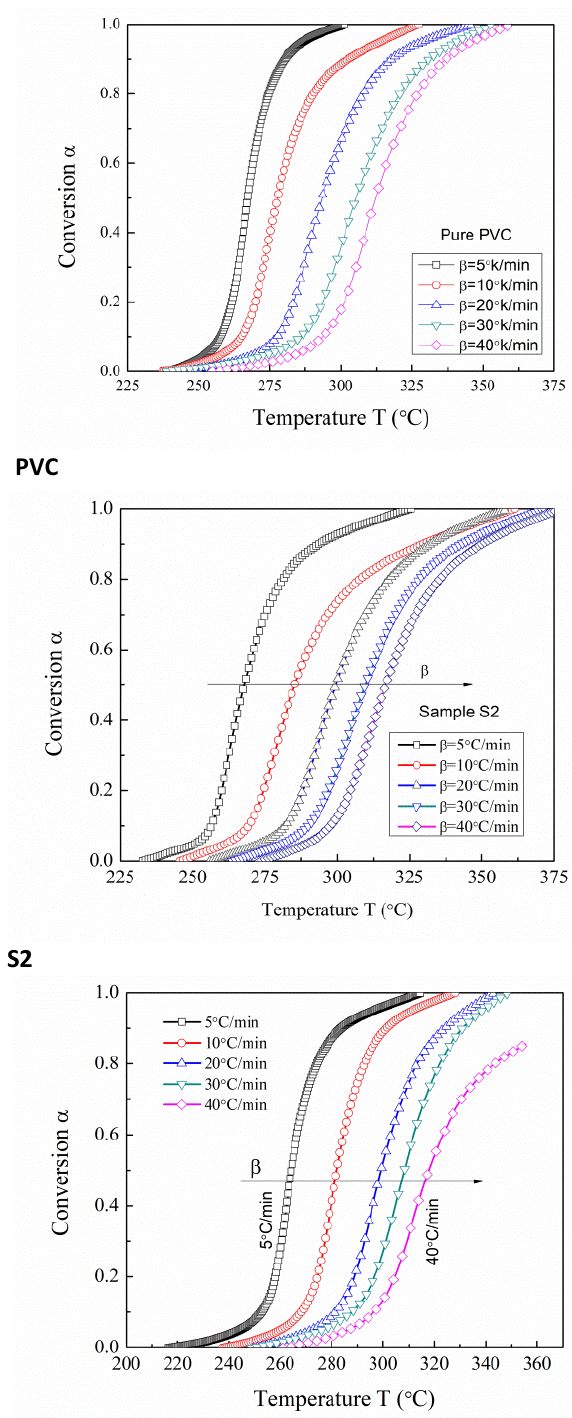
Figure 9: Variation of conversion ( α ) with temperature during first decomposition stage for pure PVC and PVC/MWCNTs nanocompos- ite samples at different heating